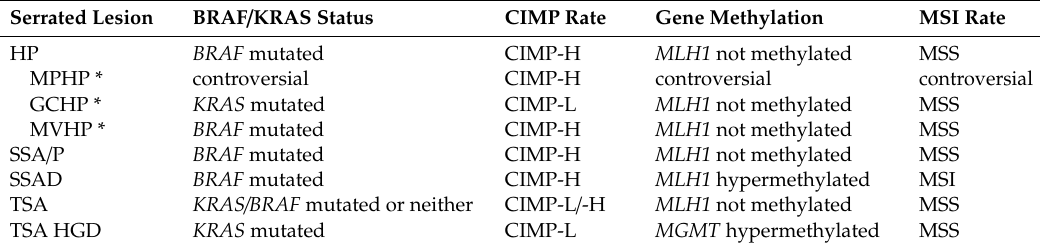
Table 3. Molecular profile of serrated colorectal